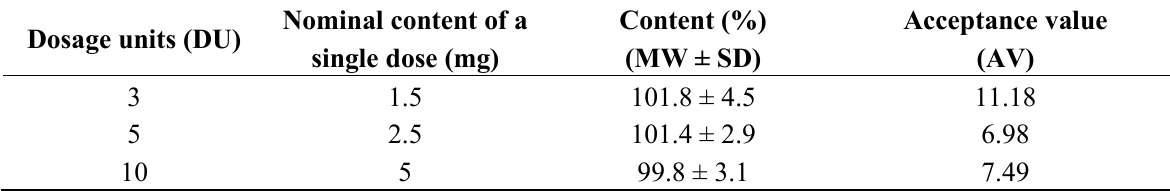
Table 2. Acceptance values according to Ph.Eur. 2.9.40 for effervescent single doses obtained by the